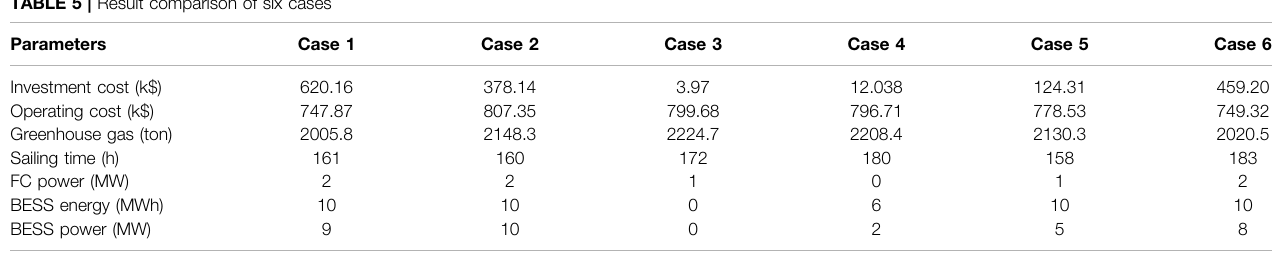
TABLE 5 | Result comparison of six cases Parameters